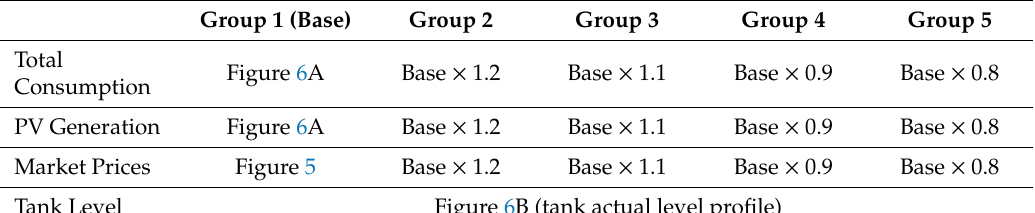
Table 2. Characteristics of the dataset created for decision tree